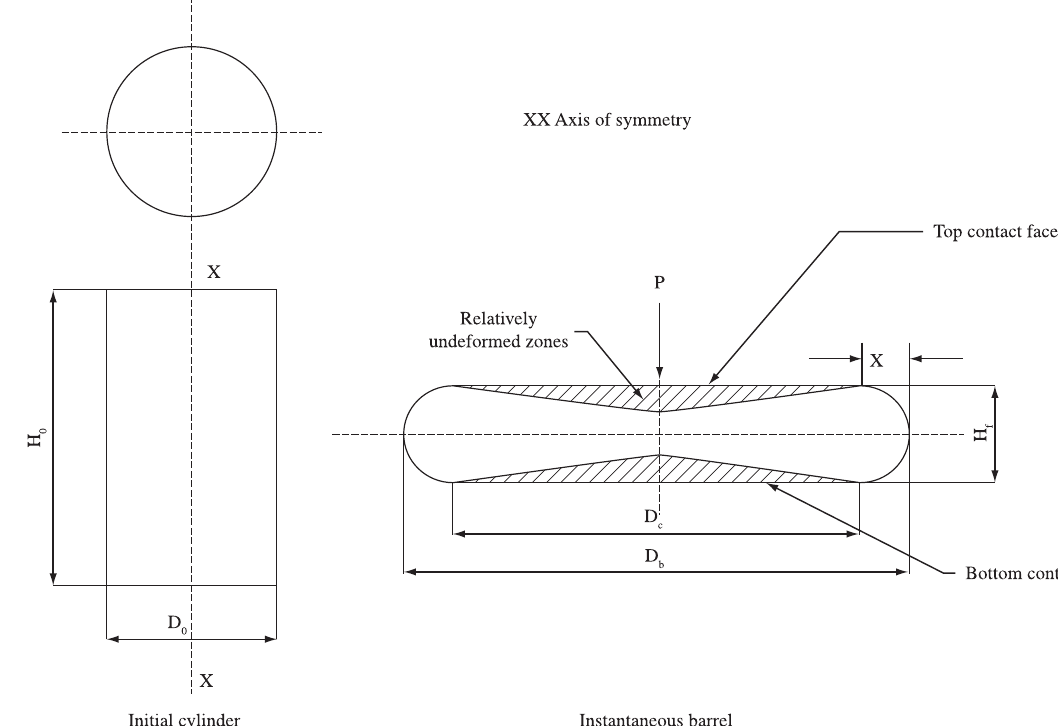
Figure 1. Schematic view of before and after deformation of the